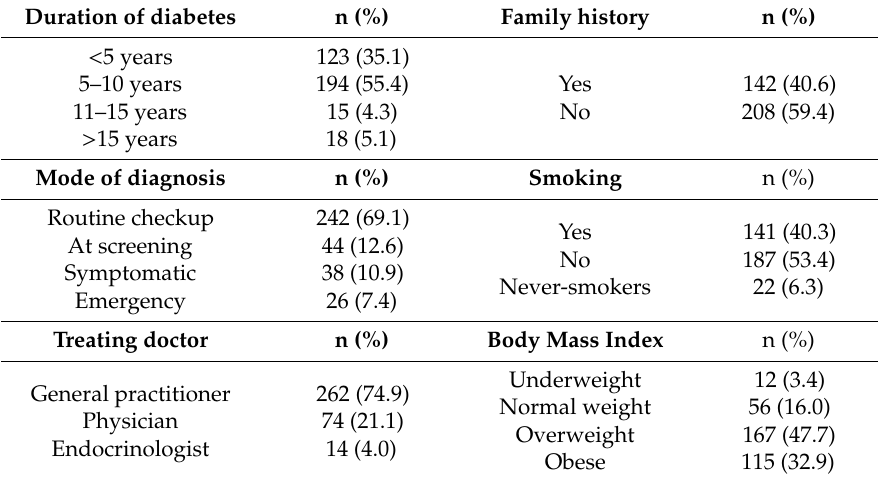
Table 1. Risk factor profile of patients (n =